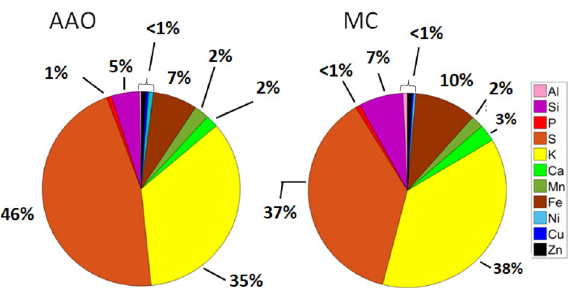
Figure 10. Pie charts of the elemental composition (determined by XRF) of atmospheric particles sampled in two different sites ( a ) AAO and ( b ) MC during the HAP